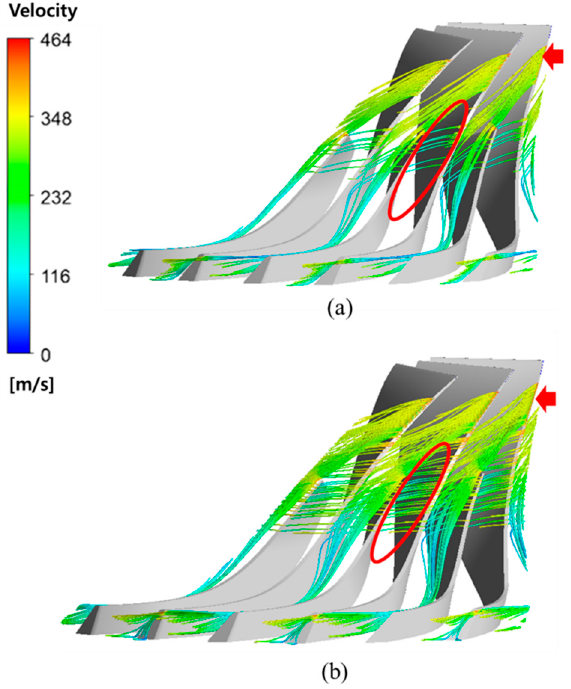
Figure 15. Comparison results of the leakage flow between the ( a ) dry and ( b ) wet compression.